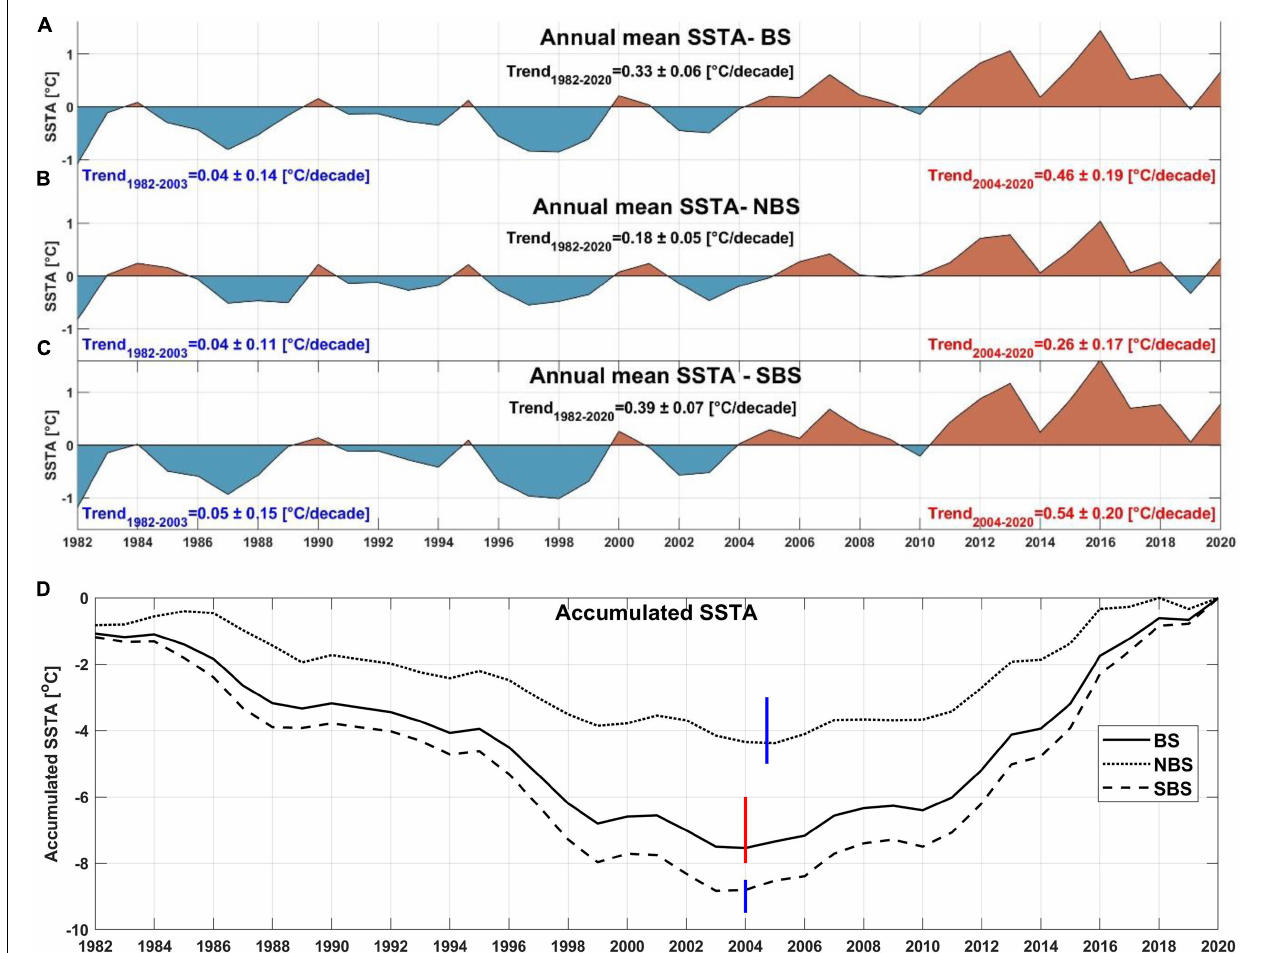
FIGURE 2 | The temporal evolution of regionally averaged annual mean SST anomalies over (A) the entire (BS), (B) northern (NBS), and (C) southern (SBS) Barents Sea from 1982 to 2020 together with (D) long-term variation of cumulative anomalies over the same domains (see Figure 1 ). The vertical blue/red dashed lines represent the corresponding climate-shift year, which occurred in 2004 and 2005 over SBS and NBS, respectively. Note that the linear trend value ( ◦ C/decade) for each region for the various time periods is also